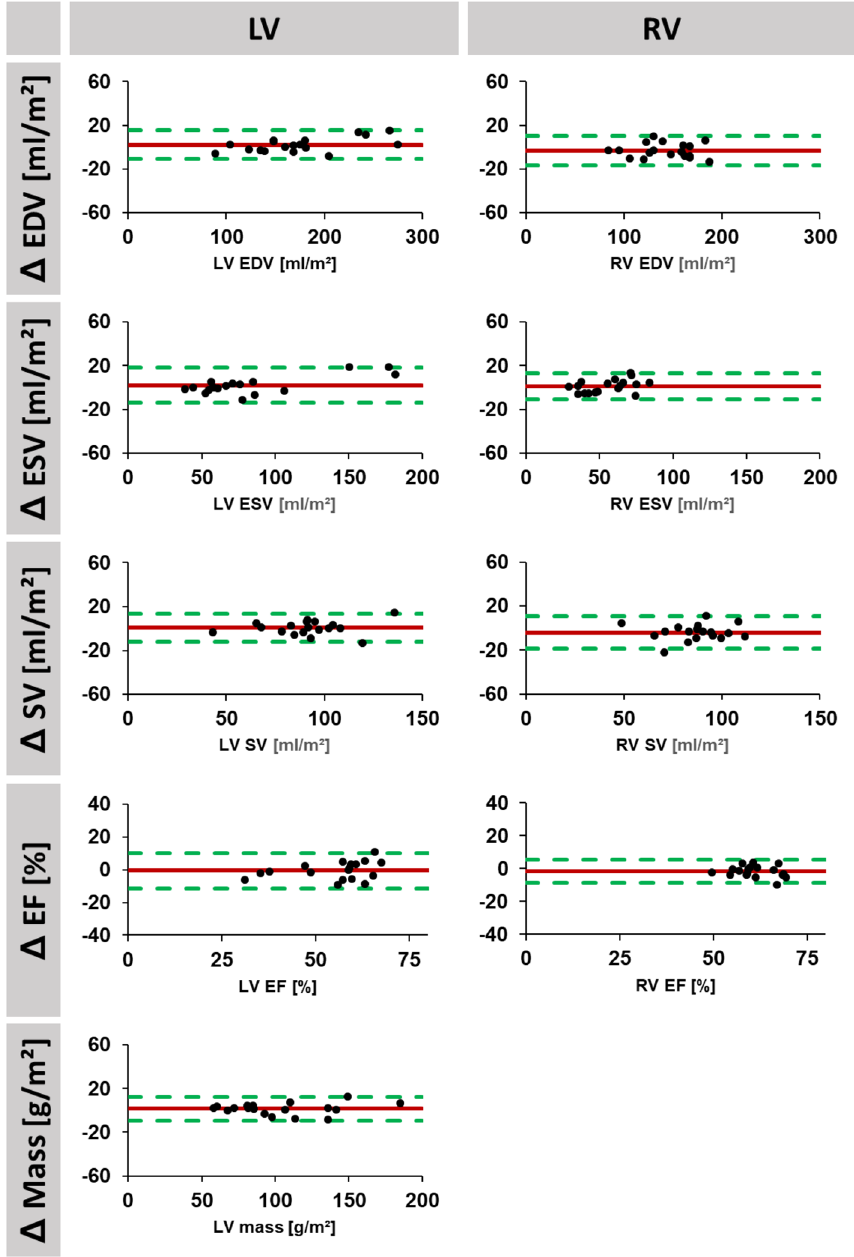
Figure 3. Agreement of short axis volume assessments based on the experienced observer. Bland Altman plots are shown for interstudy reproducibility of left (LV) and right (RV) ventricular end-diastolic (EDV) and -systolic (ESV) as well as corresponding stroke volume (SV) and ejection fraction (EF). LV assessments also included LV mass. (Δ = difference for interstudy measurements. Red: bias; green: limits of